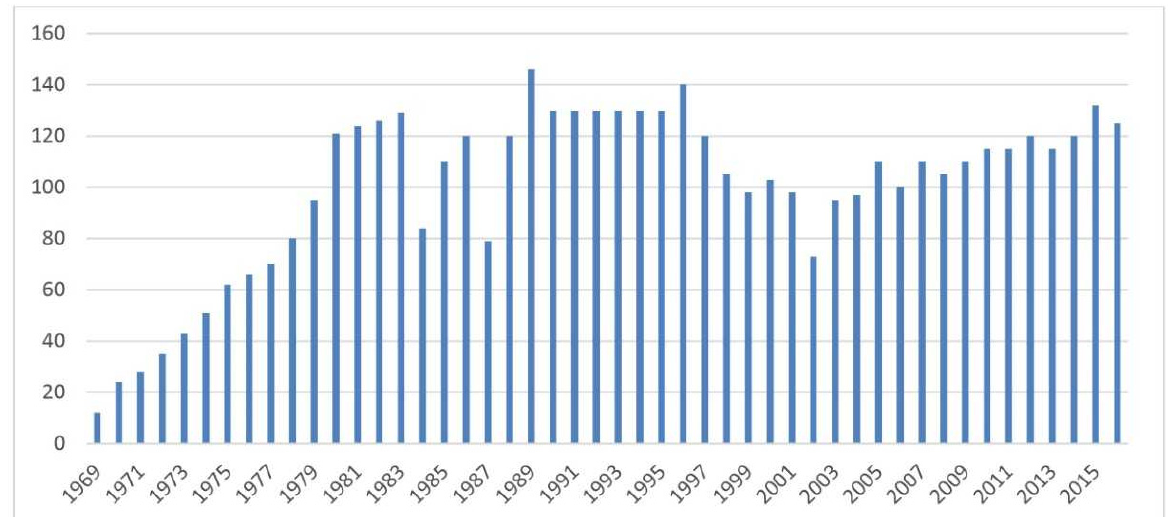
Figure 13. Number of chamois in Low Tatras between 1969 and 2015.